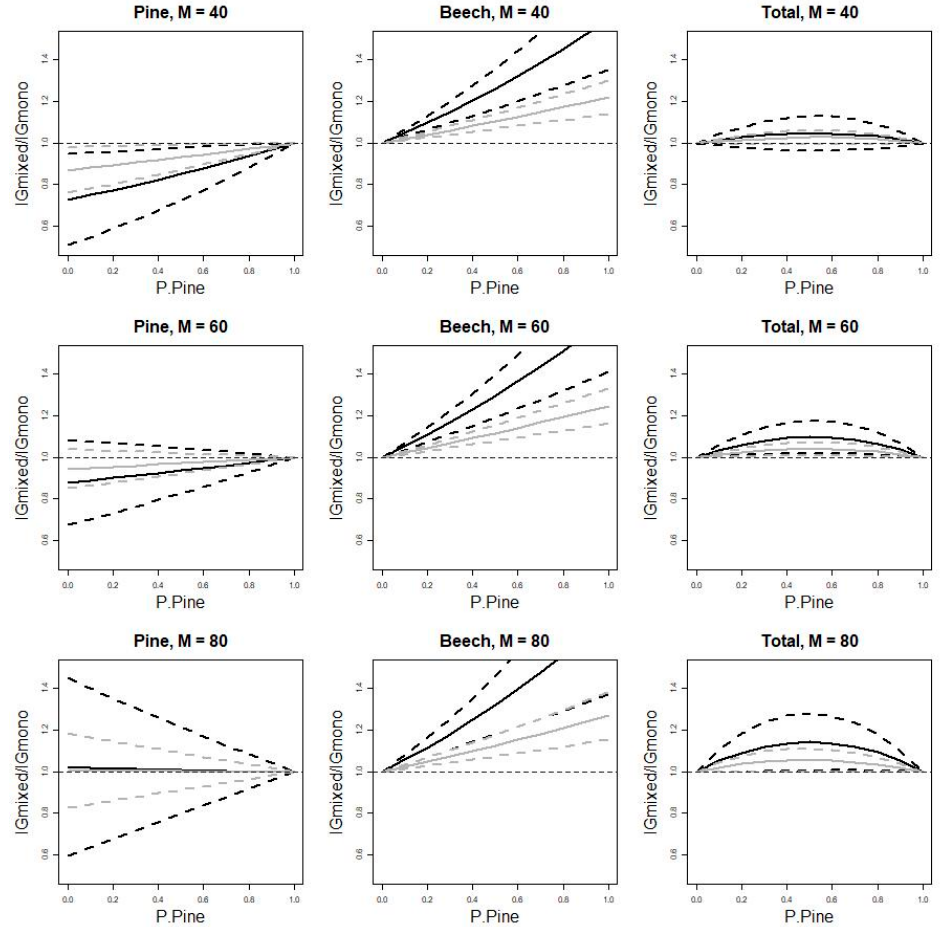
Figure 5. Variation in the ratio between basal area growth in mixtures and monospecific stands (IGmixed/IGmono) together with confidence intervals (dashed lines) versus pine proportion by area (P.Pine) for different humidity (M) and stand density conditions. RD = 0.3 is represented as light grey lines and RD = 0.7 as dark grey lines.